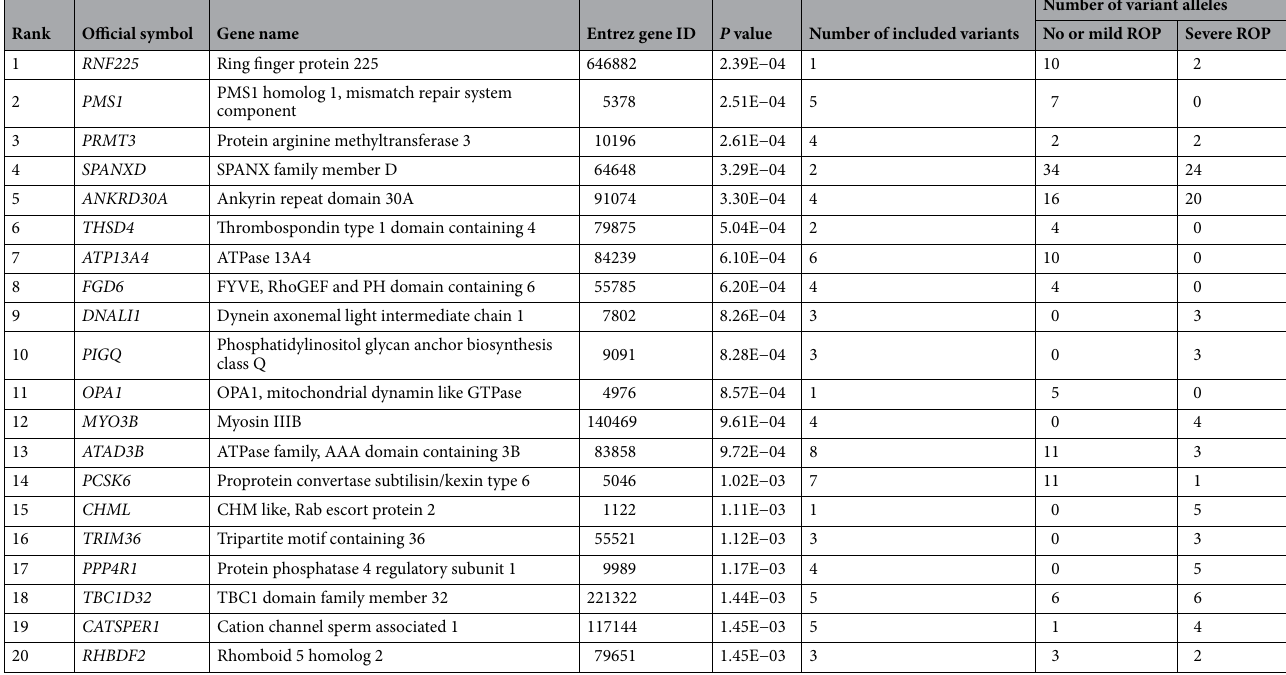
Table 2. Results of rare/low-frequency variants analysis: the 20 most strongly associated genes in 100 non- Hispanic Caucasian preterm infants by SKAT-O.